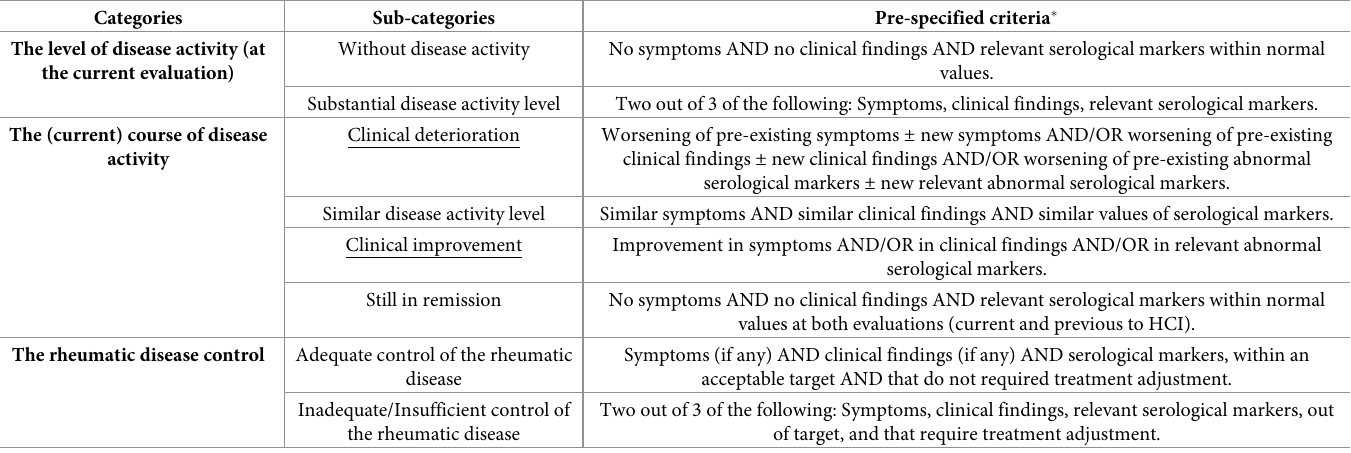
Table 2. Categories related to the rheumatic disease clinical status and the corresponding pre-specified criteria.